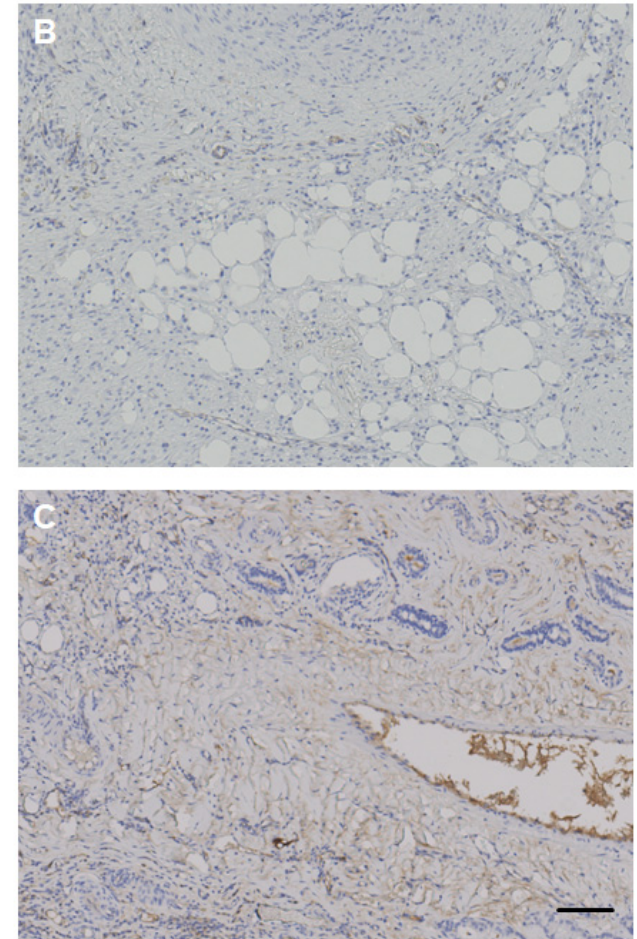
Figure 7. CD31 (angiogenesis) staining of vascularized mSVF explants after two and six weeks. ( A ) Statistical analysis of CD31 staining comparing vascularized mSVF explants after two and six weeks. Representative CD31 stainings of vascularized mSVF after ( B ) 2 weeks and ( C ) 6 weeks are depicted with brown color indicating positive CD31 expression. Bar: 100 µm. ** p < 0.01.